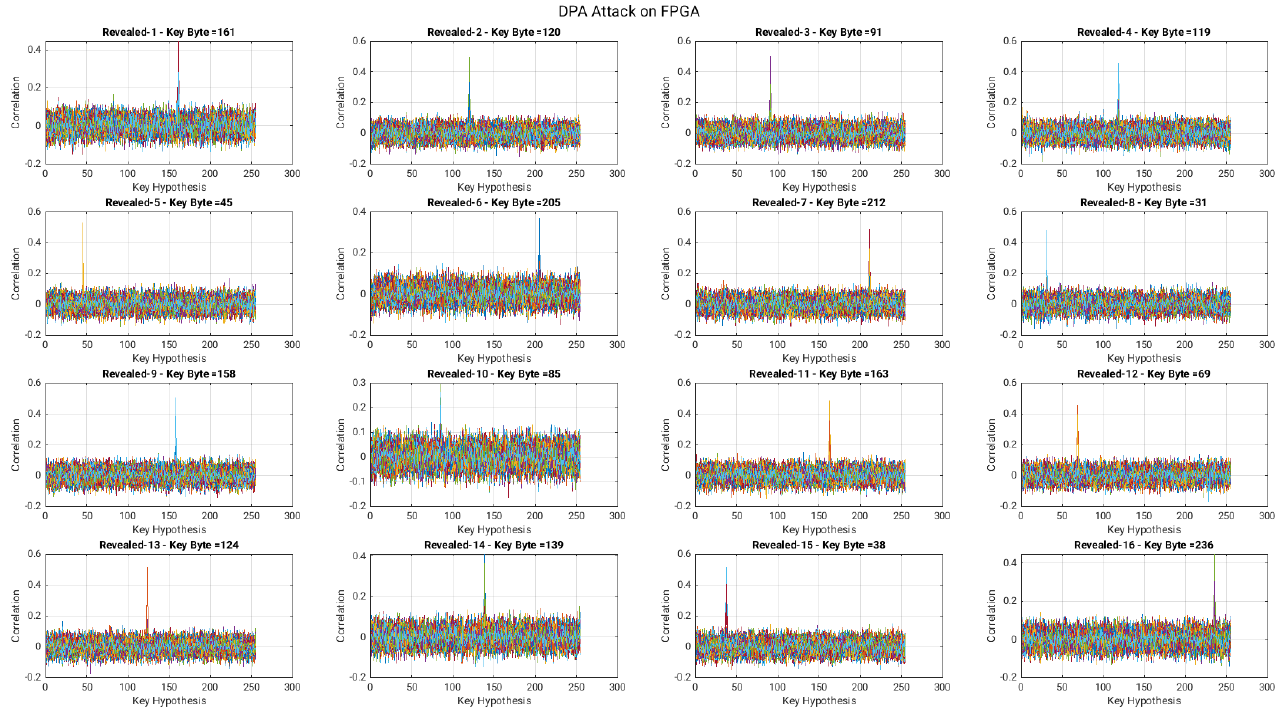
Figure A1. DPA attack on AES without the countermeasure.